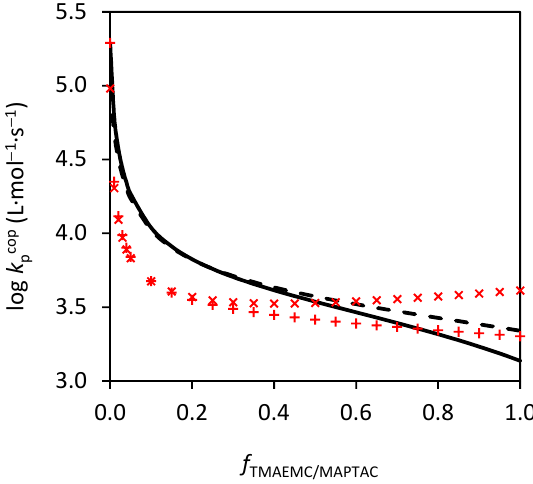
Figure 9. Comparison of log k cop p calculated at 50 ◦ C as a function of MAPTAC / TMAEMC molar fraction at w mon,0 = 0.10 (—) and 0.40 (- - -) for MAPTAC and w mon,0 = 0.10 ( + ) and 0.40 ( × ) for TMAEMC.